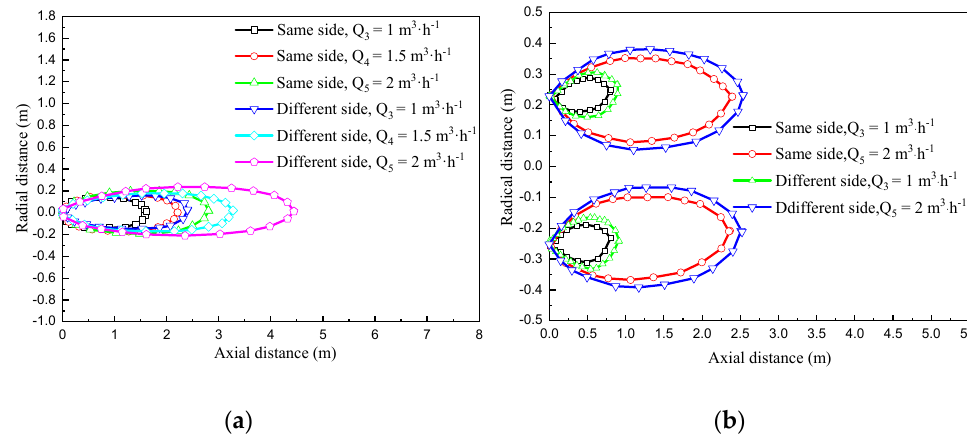
Figure 10. Oxygen-enriched area with different oxygen flow rates and oxygen supply modes under air-conditioning ( V in = 0.85 m·s − 1 ) in the form 1# and 2#. ( a ) 1#, ( b ) 2#.